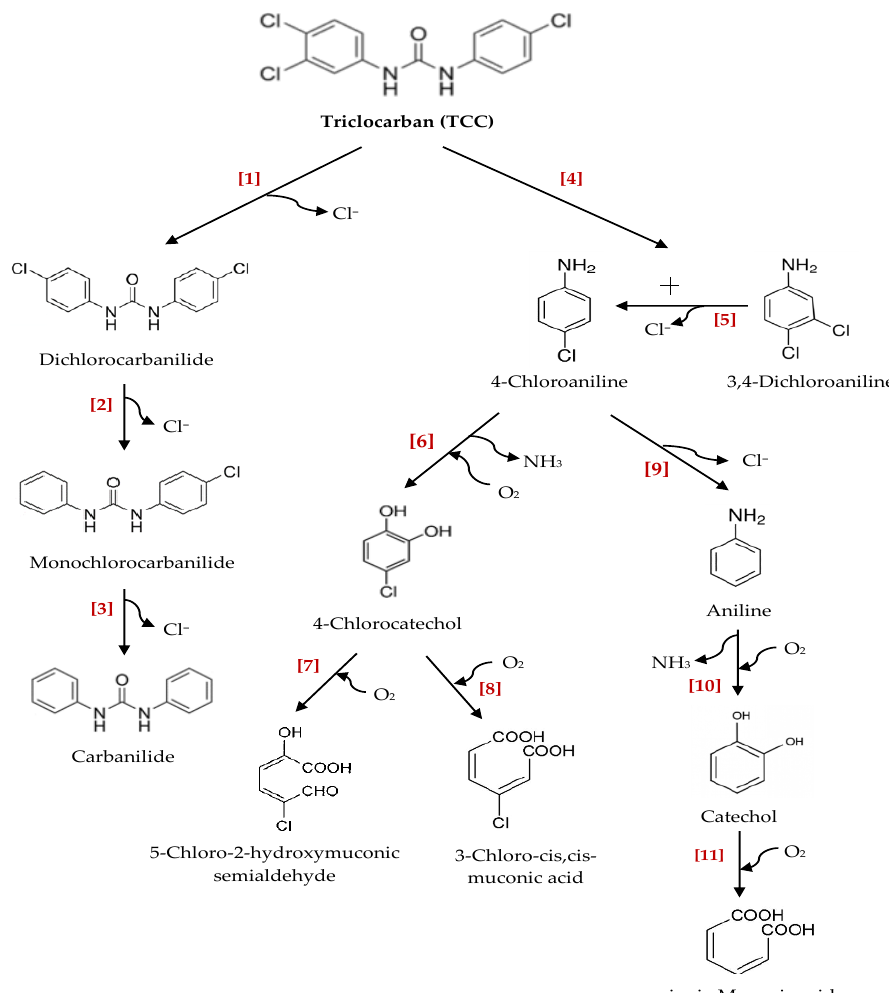
Figure 6. Proposed pathways for the potential transformation/degradation of triclocarban by microorganisms. The reactions are denoted as follows: [1–3] reductive dechlorination; [4] hydrolysis; [5] dechlorination; [6] deamination and hydroxylation; [7] meta -cleavage; [8] ortho -cleavage; [9] dechlorination; [10] deamination and hydroxylation; [11] ortho -cleavage (adapted from references [170,173,179,180]).